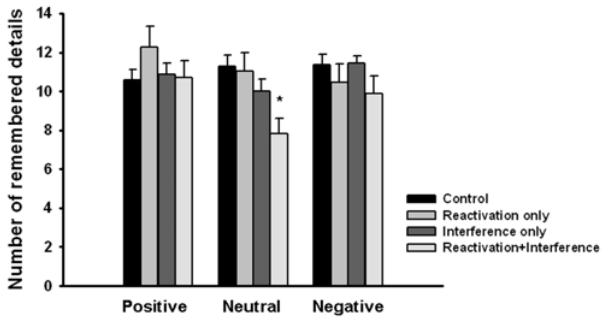
Figure 1. Number of details remembered of the positive, neutral and negative personal experiences on day 2. Neutral but not positive or negative autobiographical memories were reduced when participants learned new information after memory reactivation (* p , .01). Note that memories were about 2 weeks old when the memory test took place. Data represent means 6